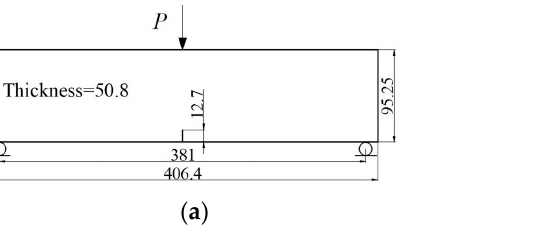
Figure 2. Impact test of a concrete beam. ( a ) Geometry (Unit: mm); ( b ) FE model.